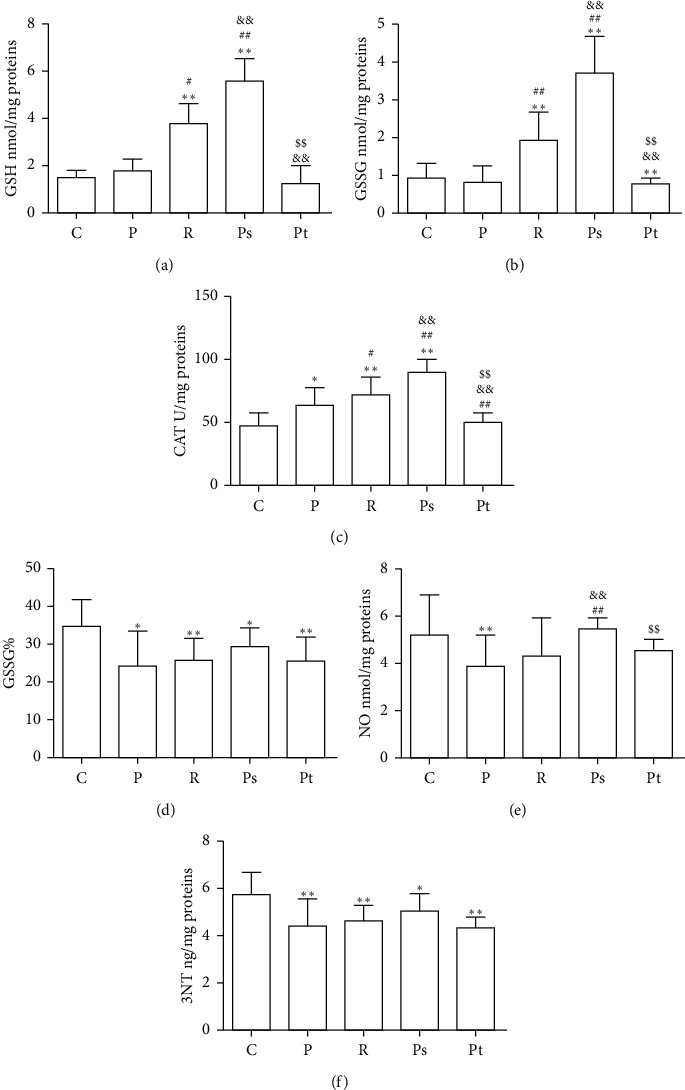
Oxidant/antioxidant response in all patients regardless of gender (mean ± SD). Levels of reduced (a) and oxidized GSH (b), CAT (c), degree of GSH oxidation (d), NO (e), and 3-nitrotyrosine (f) in the control group (C), primary pterygium (P), recurrent pterygium (R), and primary pterygium with systemic (Ps) or topical (Pt) pretreatment in all patients regardless of gender. ∗p < 0.05 and ∗∗p < 0.01 compared with group C. #p < 0.05 and ##p < 0.01 compared with the primary pterygium group. &p < 0.05 and &&p < 0.01 compared with group R. $$p < 0.01 compared groups with treatments.